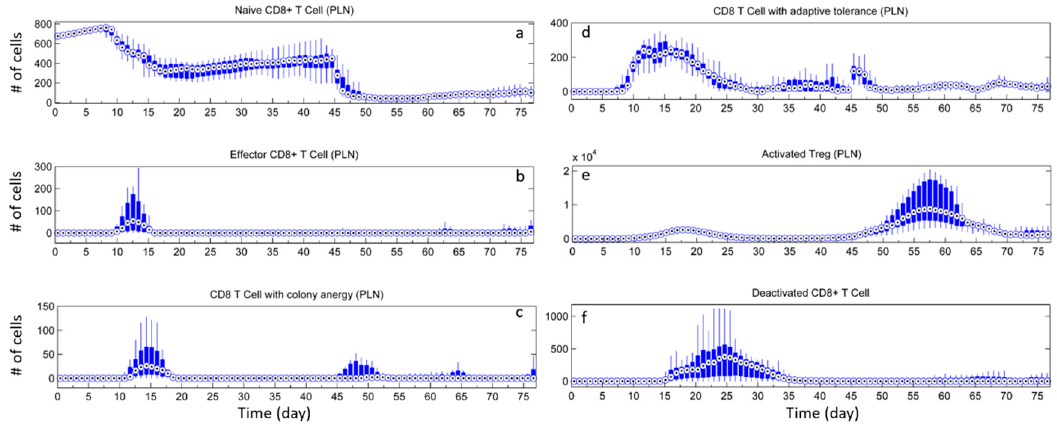
Figure A6. Simulation results for case without inhibiting DCs (case V). Tregs cannot inhibit DCs but can directly inhibit T cells. The number of ( a ) naive CD8 + T cells, ( b ) effector CD8 + T cells, ( c ) CD8 + T cells with colony anergy, ( d ) CD8 + T cells with adaptive tolerance, ( e ) activated Tregs in PLN and the number of ( f ) deactivated CD8 + T cells in pancreatic tissue are shown. t = 0 days correspond to 3-week age of mouse.